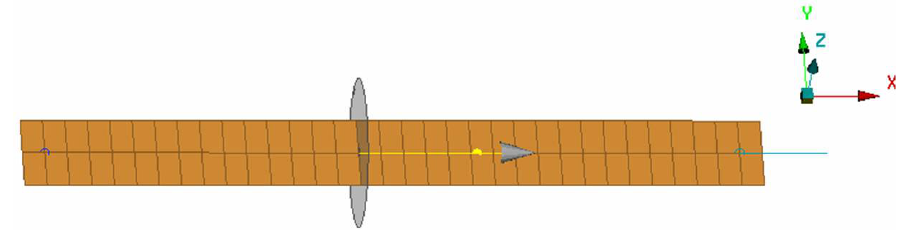
Figure 3. Finite element model of the tensile specimen.